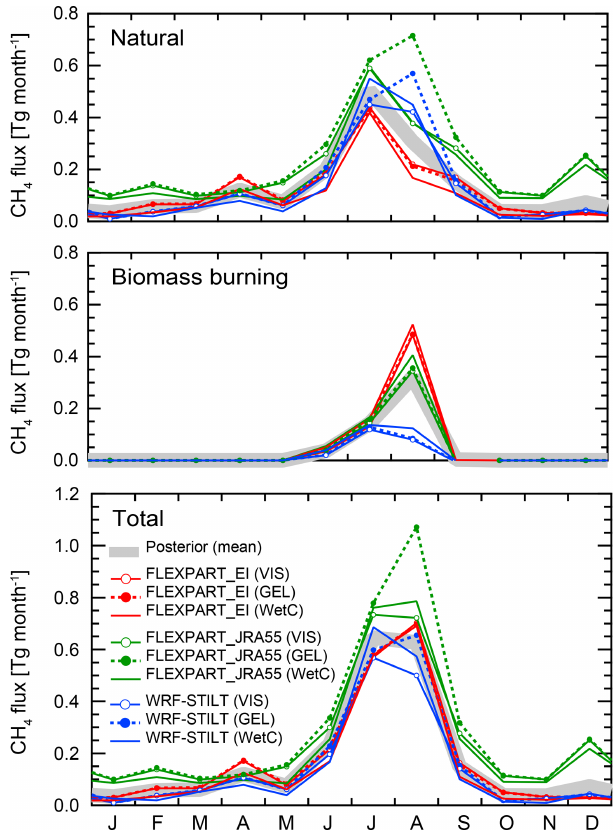
Figure 9. Examples of monthly posterior fluxes by nine inver- sion experiments of three different models (FLEXPART_EI, FLEX- PART_JRA55, and WRF-STILT) with three prior emission cases (VIS, GEL, and WetC). The posterior fluxes are plotted for subre- gion YT + NT in mask B. The posterior flux means of nine exper- iments with mask B are also plotted. These monthly fluxes are for the year 2014.